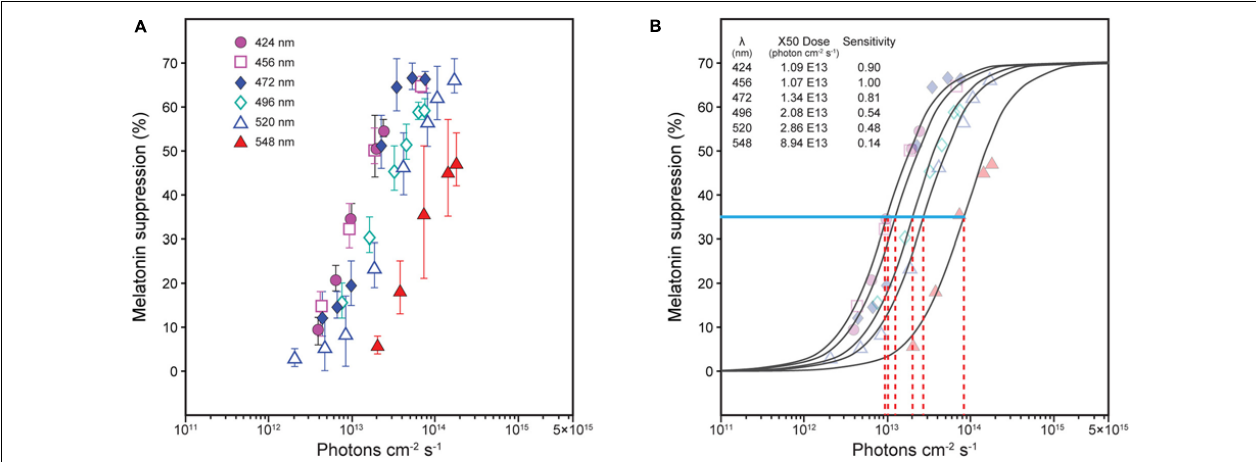
FIGURE 1 | Nocturnal melatonin suppression for different narrowband spectra [ (A) , Thapan et al. (2001)]. To determine spectral sensitivity, the amount of photon rate density (photons cm − 2 s − 1 ) needed at each wavelength [ (B) , red dashed lines] to reach half-saturation [ (B) , blue solid line, ≈ 35% suppression] is plotted relative to the wavelength requiring the least amount of energy to reach half-saturation (maximum sensitivity). Two sets of derived spectral sensitivity estimates using this procedure, both using irradiance rather than photon rate density at the eye were developed, one for Thapan et al. (2001) and one from Brainard et al. (2001), as shown in Figure 2